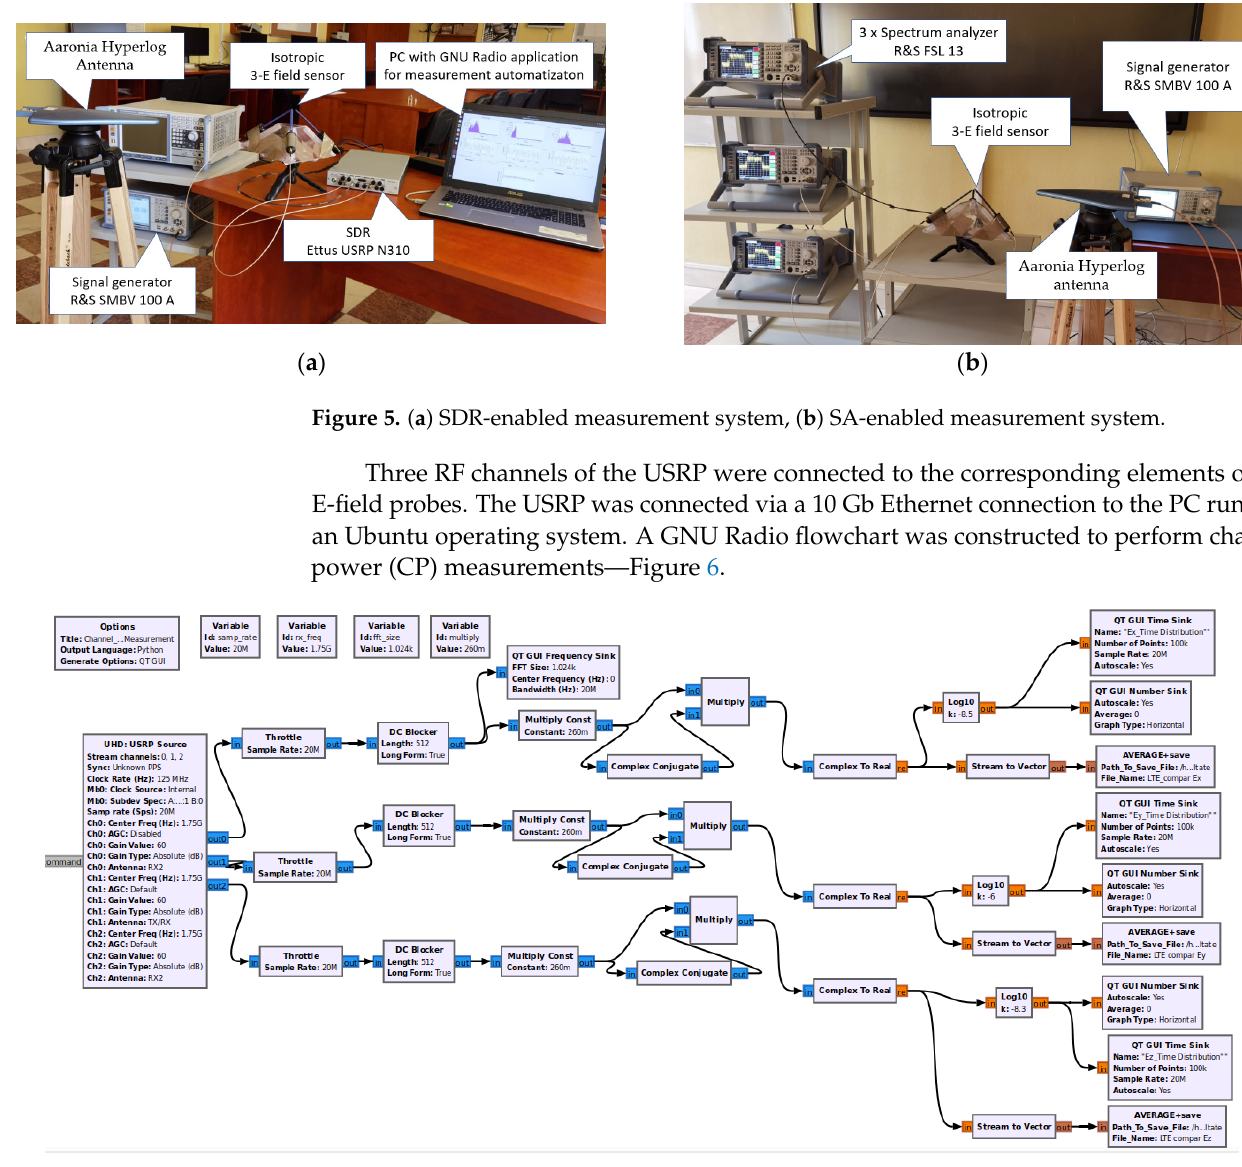
Figure 6. GNU Radio flowchart used for CP measurements using the SDR (USRP N310).